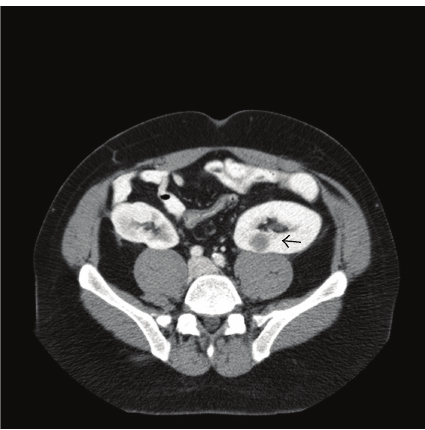
Figure 1: Metastatic melanoma, left kidney